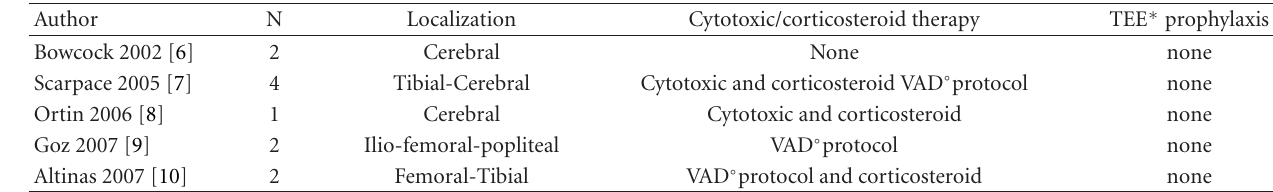
Table 1: Arterial complication during Thalidomide administration for MM.